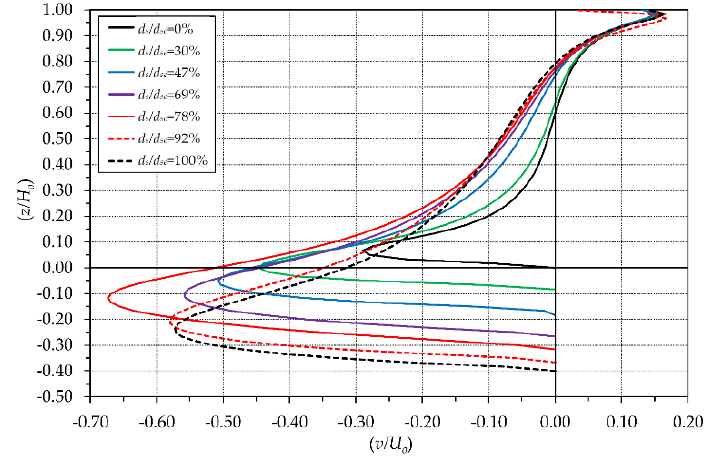
Figure 13. Vertical velocity distribution at X/D = 0.05 during the scouring process.